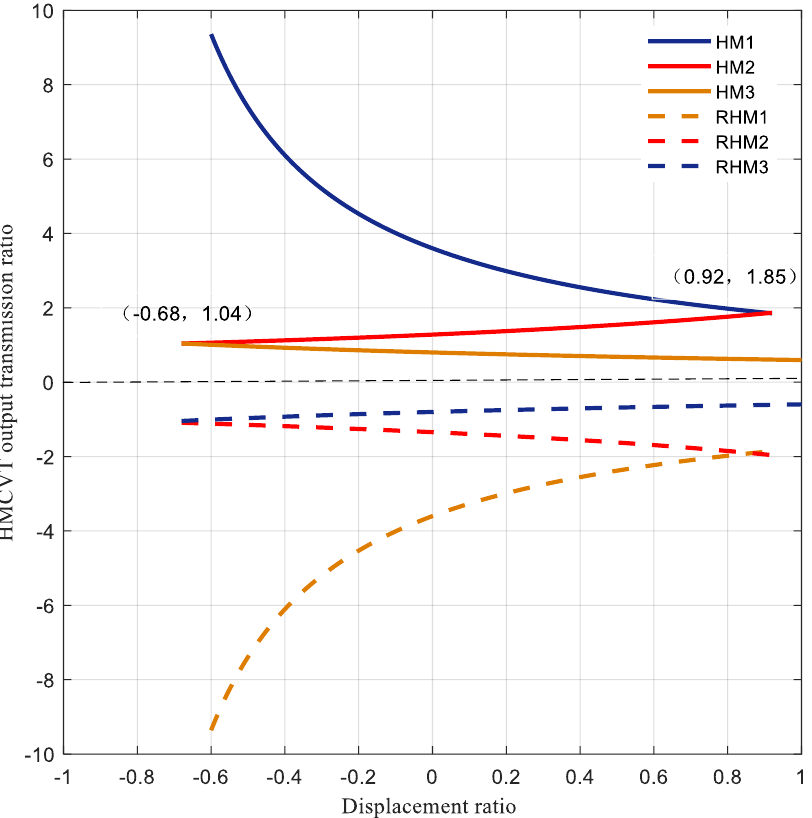
Figure 3. Transmission ratio output characteristic diagram of HMCVT.